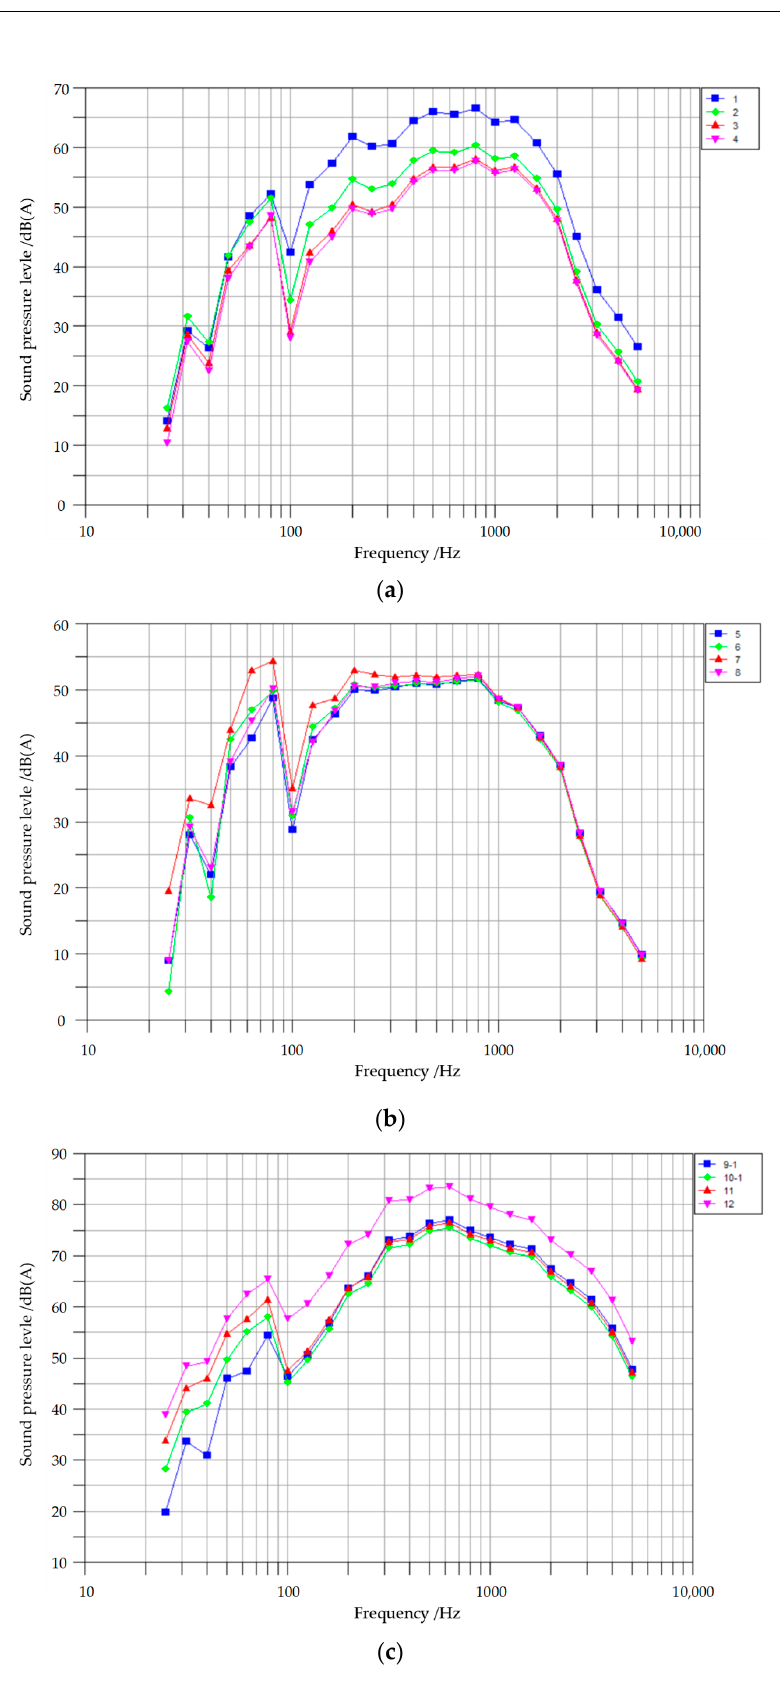
Figure 11. Spectrum of interior aerodynamic noise: ( a ) Spectrum characteristics of the head car, ( b ) spectrum characteristics of the middle car, ( c ) spectrum characteristics of the tail car.